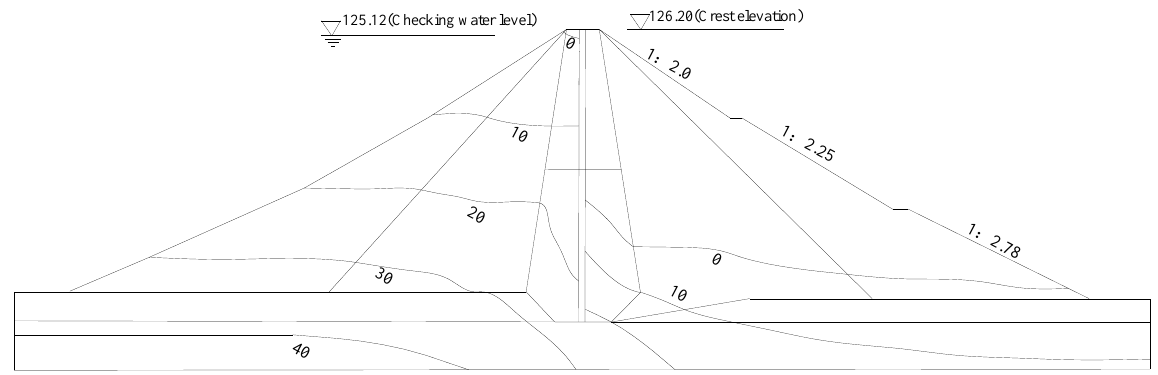
Figure 8. Isograms of pressure head for the main dam though the common method.